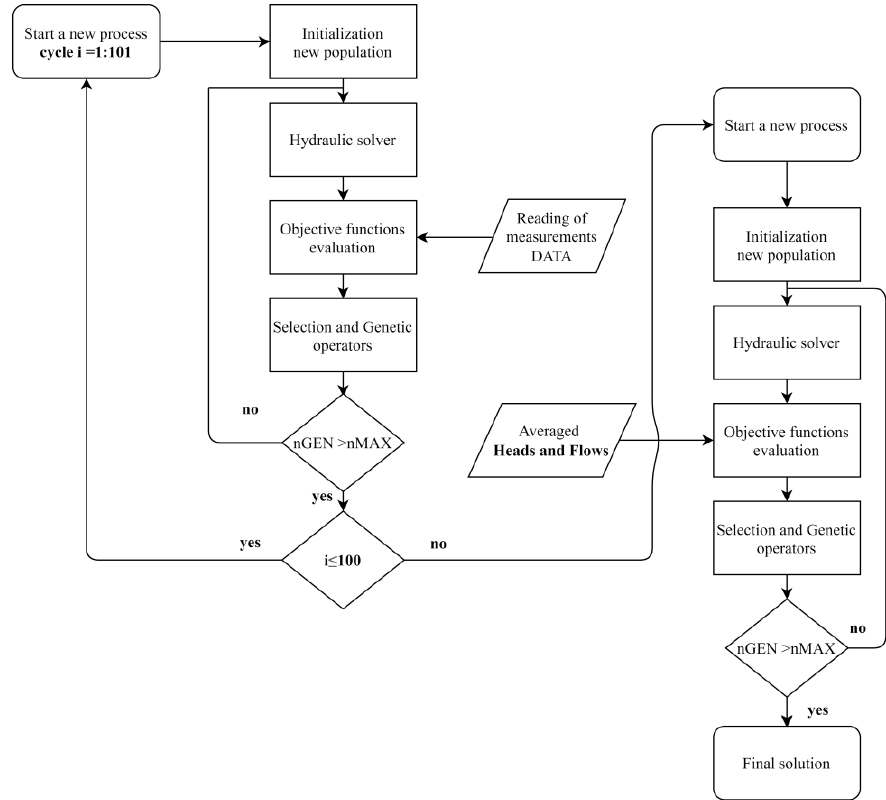
Figure 1. Calibration procedure flow-chart.